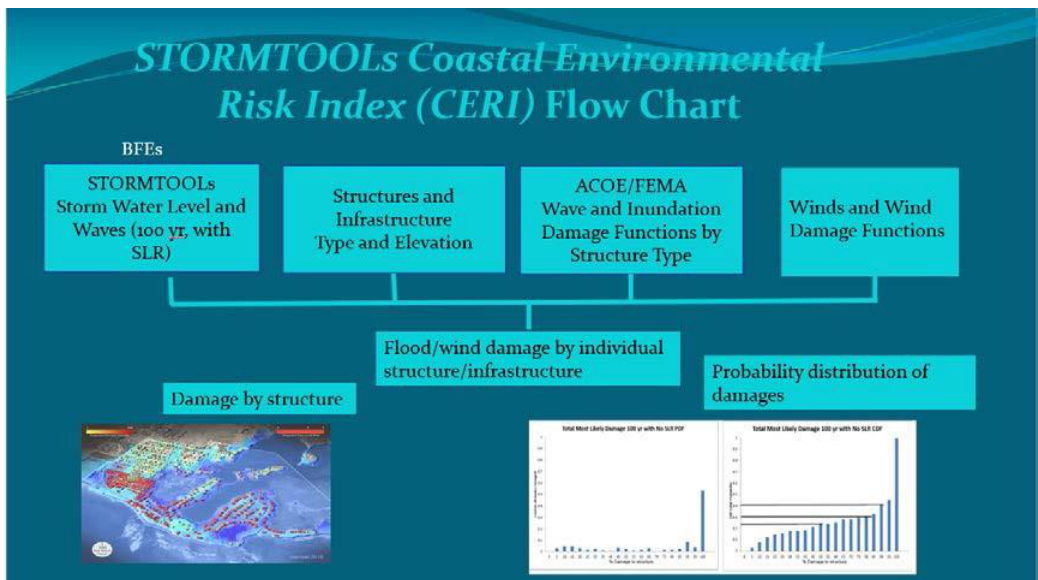
Figure 1. Flow chart for STORMTOOLS coastal environmental risk index (CERI). Reproduced from [1], with permission from MDPI, 2020.